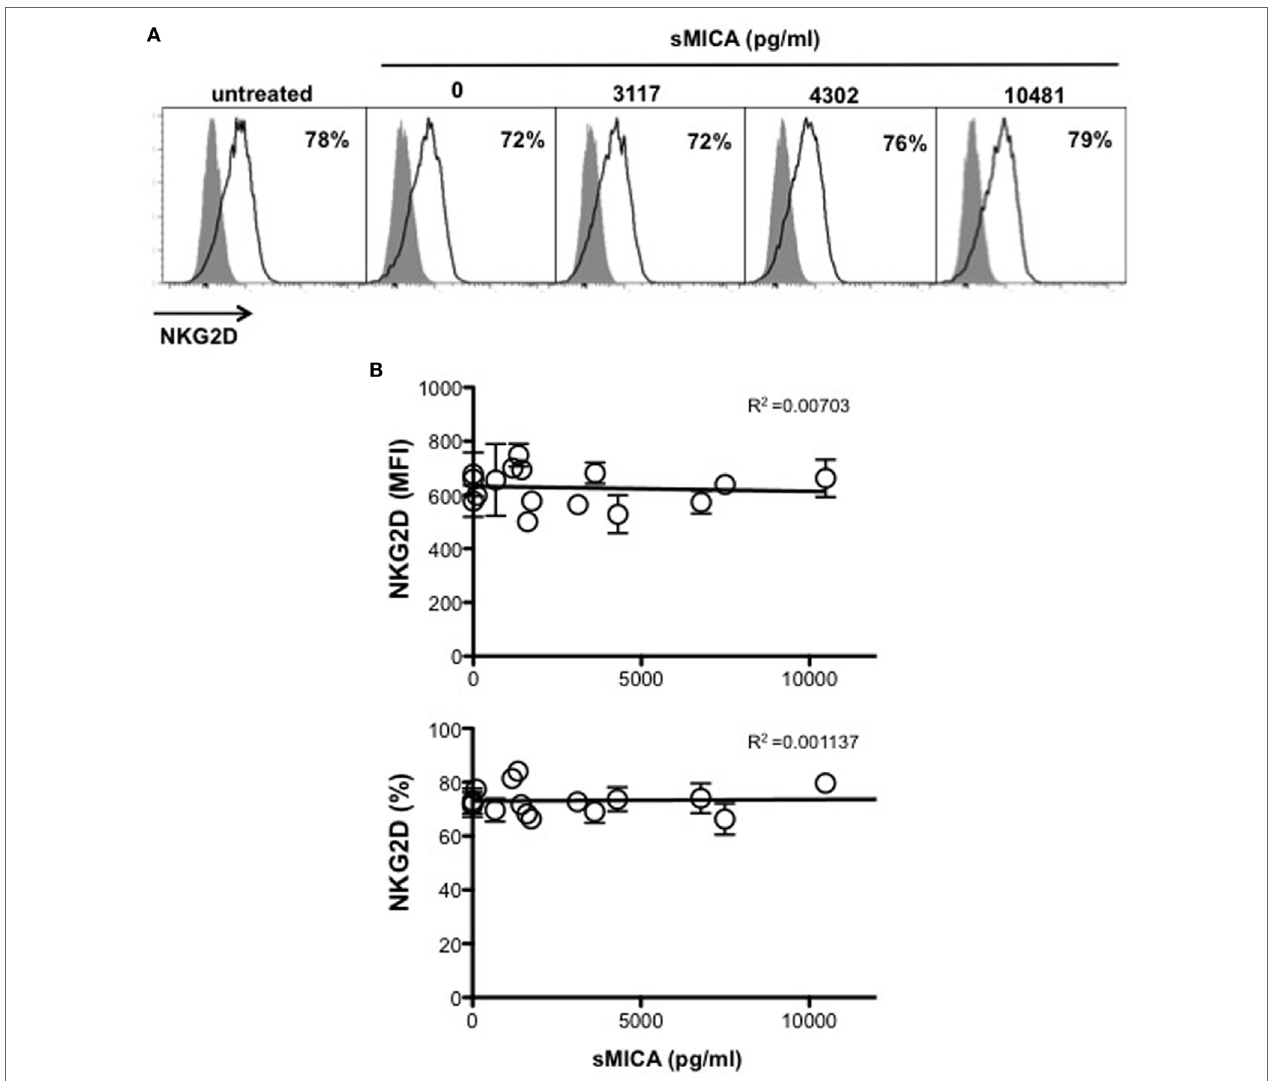
FigUre 5 | Soluble MICA levels in the serum of multiple myeloma (MM) patients carrying the Val allele do not correlate with change in NKG2D expression. Peripheral blood derived from healthy donors were incubated for 16 h with medium alone or serum derived from MGUS or MM patients at different disease states carrying at least one Val allele and containing variable levels of soluble MICA. Cells were harvested and NKG2D expression was evaluated by gating on CD3 − CD56 + natural killer (NK) cells. (a) A representative experiment is shown. (B) Values reported on y axis represent the MFI value of NKG2D subtracted from the MFI value of the isotypic cIg (high panel) or the percentage of NKG2D positive cells (lower panel) and were correlated with soluble MICA levels of each patient as indicated on x axis . Total number of serum patients analyzed, n = 16 (3 MGUS, 6 smoldering, 6 onset, 1